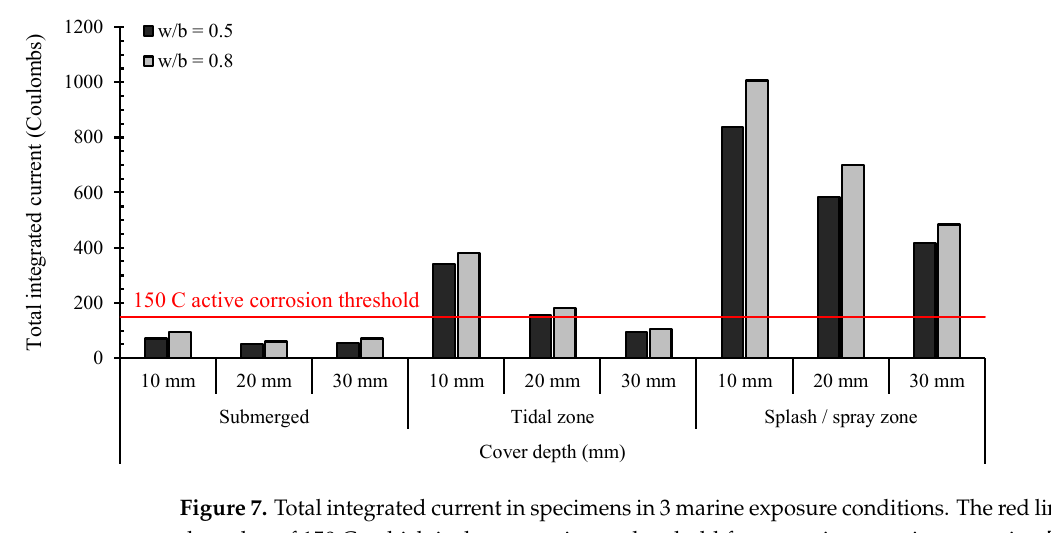
Figure 7. Total integrated current in specimens in 3 marine exposure conditions. The red line indicates the value of 150 C, which is the approximate threshold from passive to active corrosion [16].